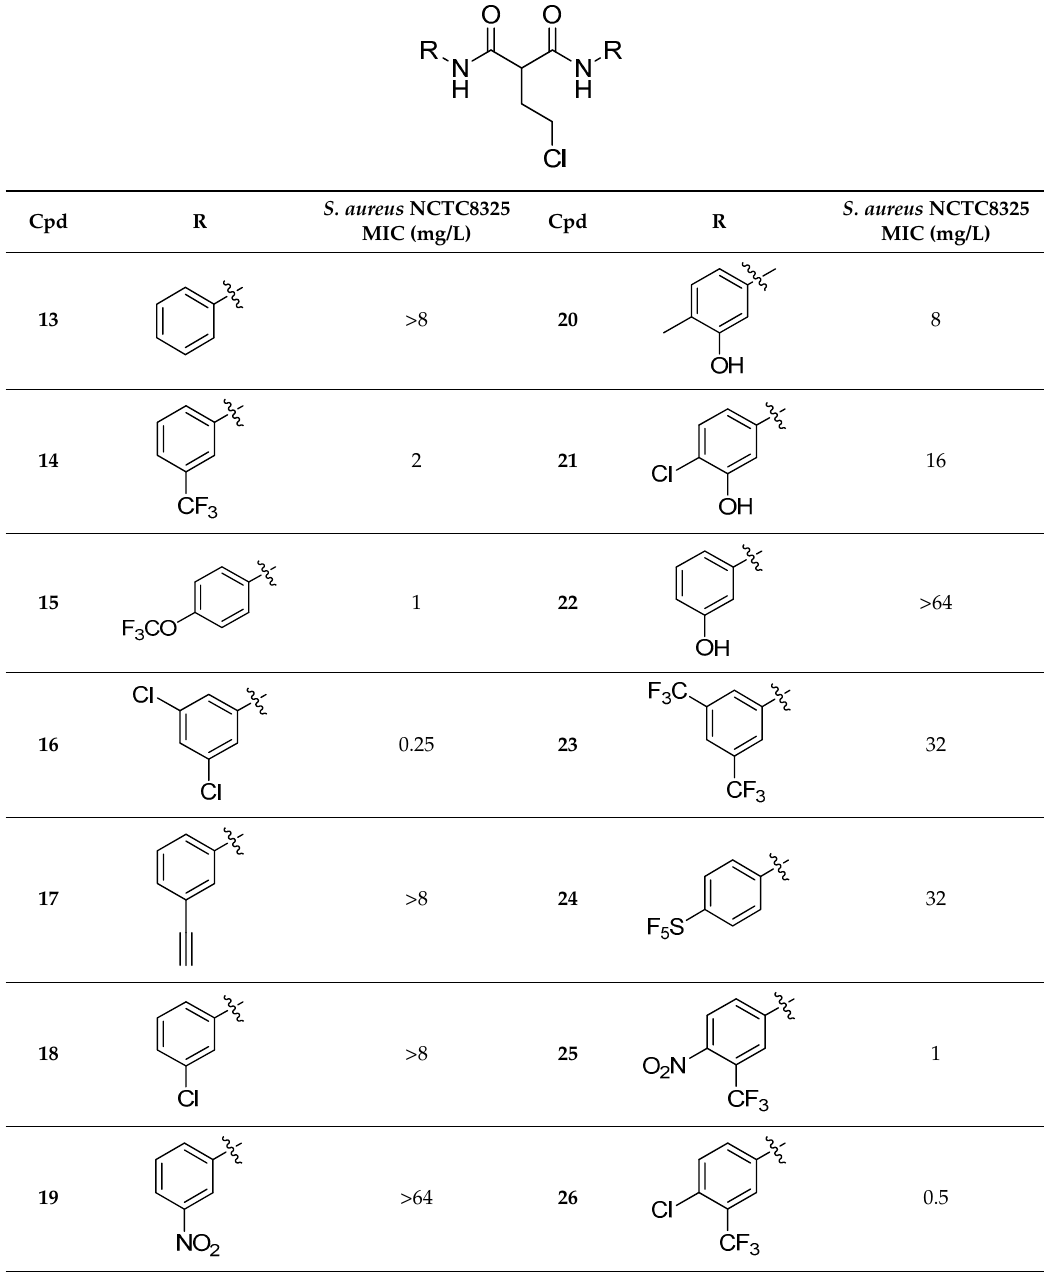
Table 1. Antibacterial activity of symmetric ethyl chloride malonate derivatives against S. aureus NCTC8325.